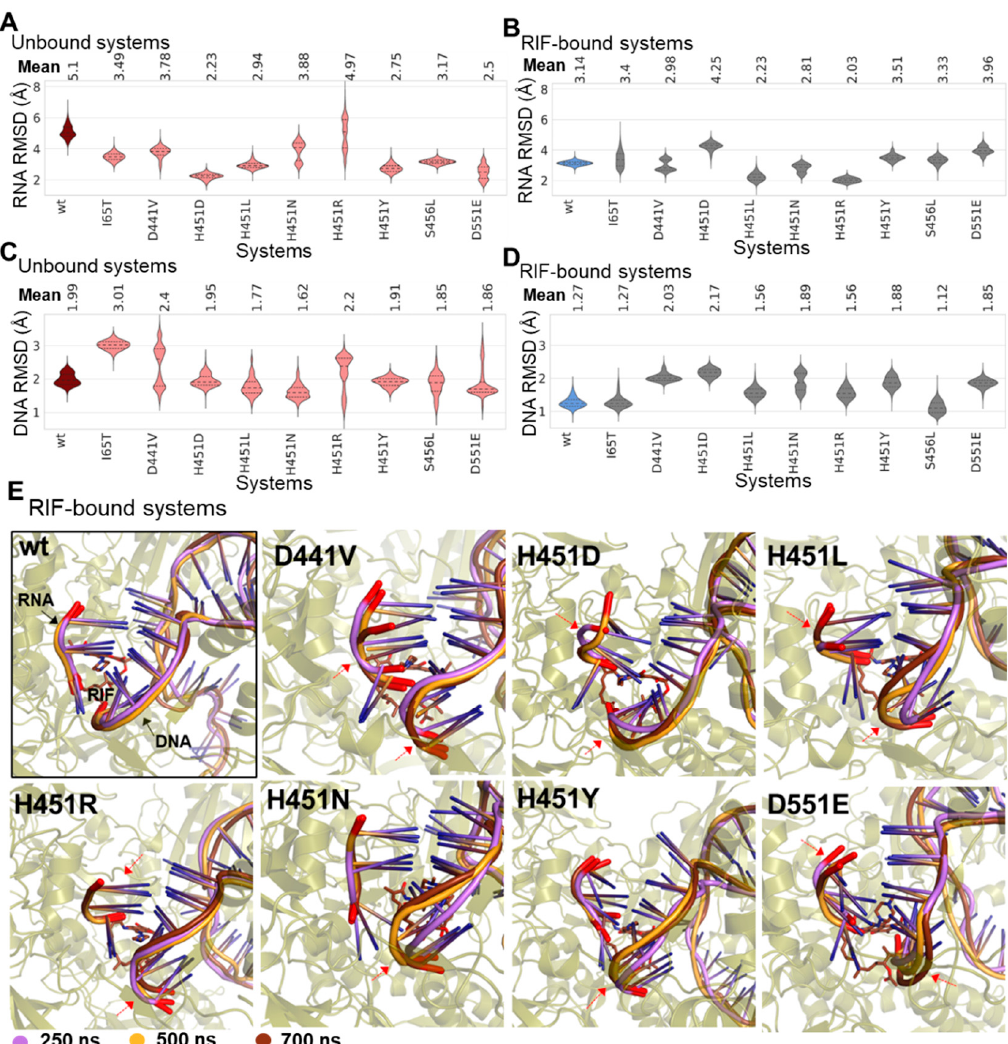
Figure 7. Structure-dynamic analyses of mutational and RIF-binding effects on catalytic nucleic acids. ( A ) Comparative RMSD violin plots for catalytic RNAs in unbound wt (maroon) and mt (pink) systems and ( B ) catalytic RNAs in RIF-bound protein systems. The mean RMSD values are indicated above the plots, while the dotted lines on the violins represent the 25th, 50th and 75th quartiles. RMSD violin plots for corresponding 4nt DNA moieties are also shown for ( C ) unbound wt and mt systems and ( D ) RIF-bound proteins. ( E ) Three-dimensional superimposition of the RNA and DNA moieties for the studied systems. Snapshots used were retrieved from 250 ns (colored purple), 500 ns (orange) and 750 ns (brown). Regions with distinctive alterations are indicated with red arrows.